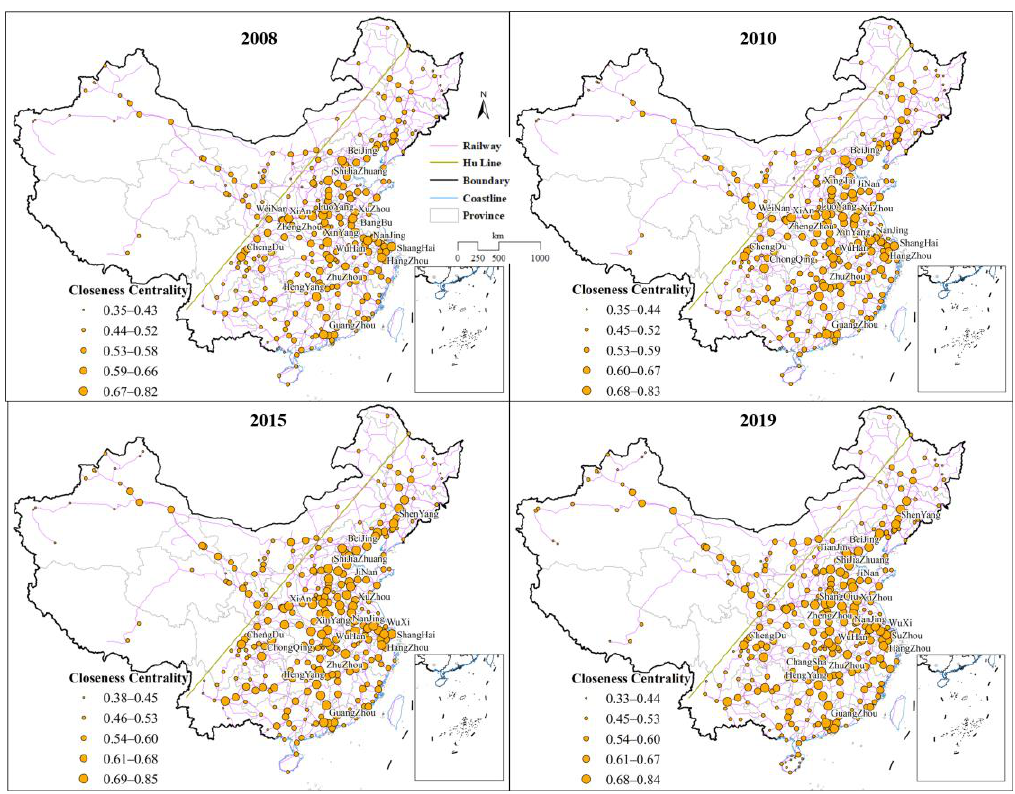
Figure 4. The maps of closeness centrality values in different years.